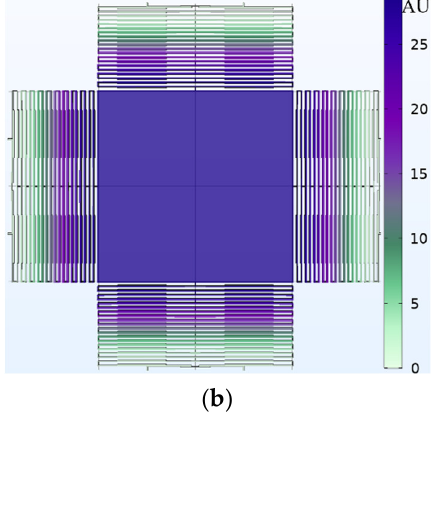
Figure 8. The relation between displacement and applied acceleration for each design is shown. The slope of each graph represents the vertical and lateral mechanical sensitivity of the three proposed optical accelerometer designs: ( a ) Design 1, ( b ) design 2, ( c ) design 3.